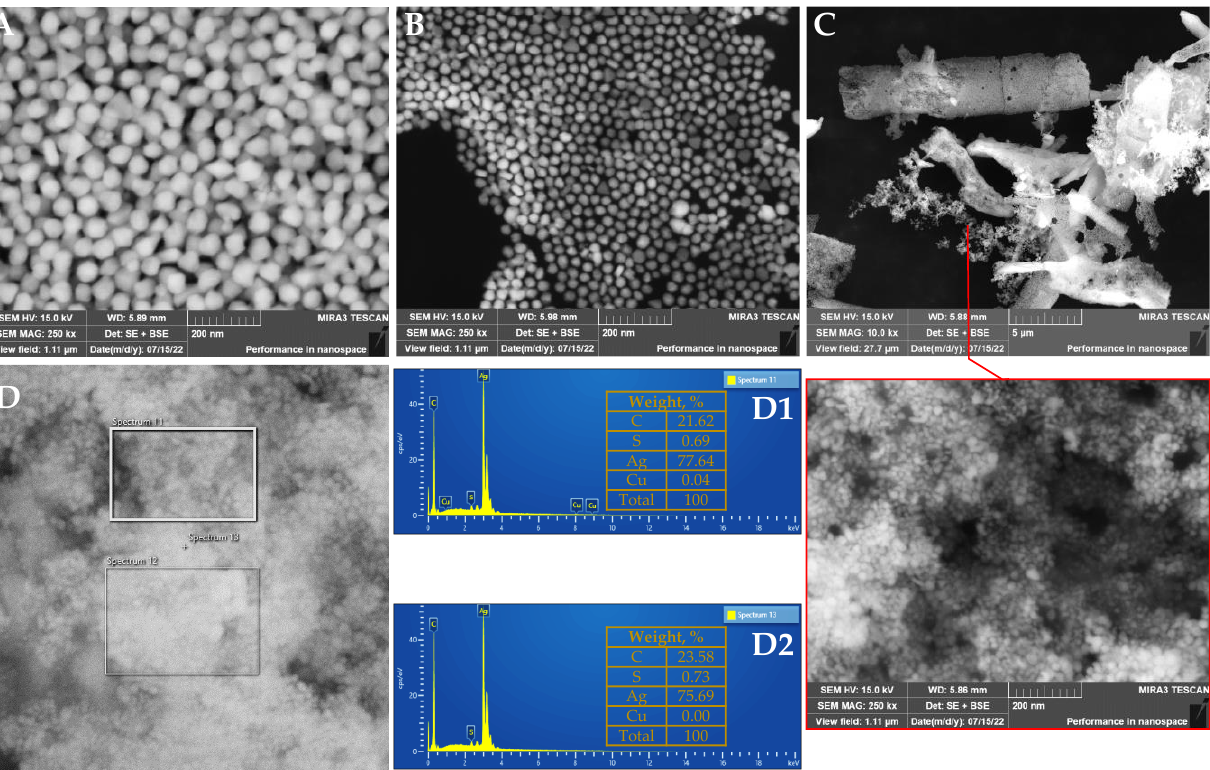
Figure 6. Scanning electron microscopy (SEM) images of uncapped ( A ) and capped ( B ) with polyvinylpyrrolidone synthesized silver nanoparticles produced by synthetic trans -ferulic acid, capped silver nanoparticles produced by rye bran-derived trans -ferulic acid and trans - iso -ferulic acids ( C ). EDS patterns ( D , D1 , D2 ) of silver nanoparticles produced by rye bran-derived trans -ferulic acid and trans - iso -ferulic acids captured at two randomly selected regions for EDS analysis.